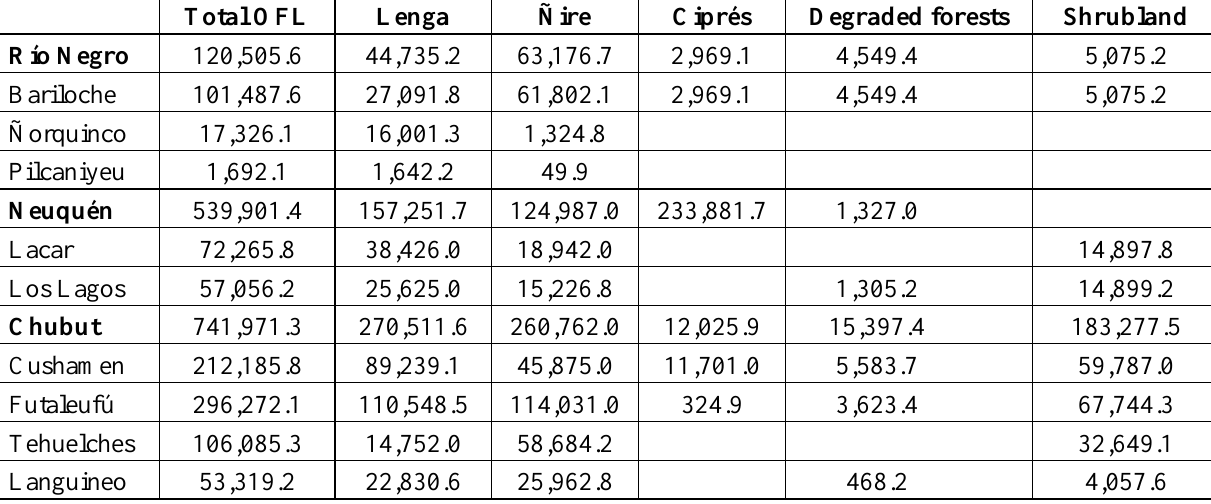
Table 8. Distribution and type of forests in Other Forestlands (ha). Total